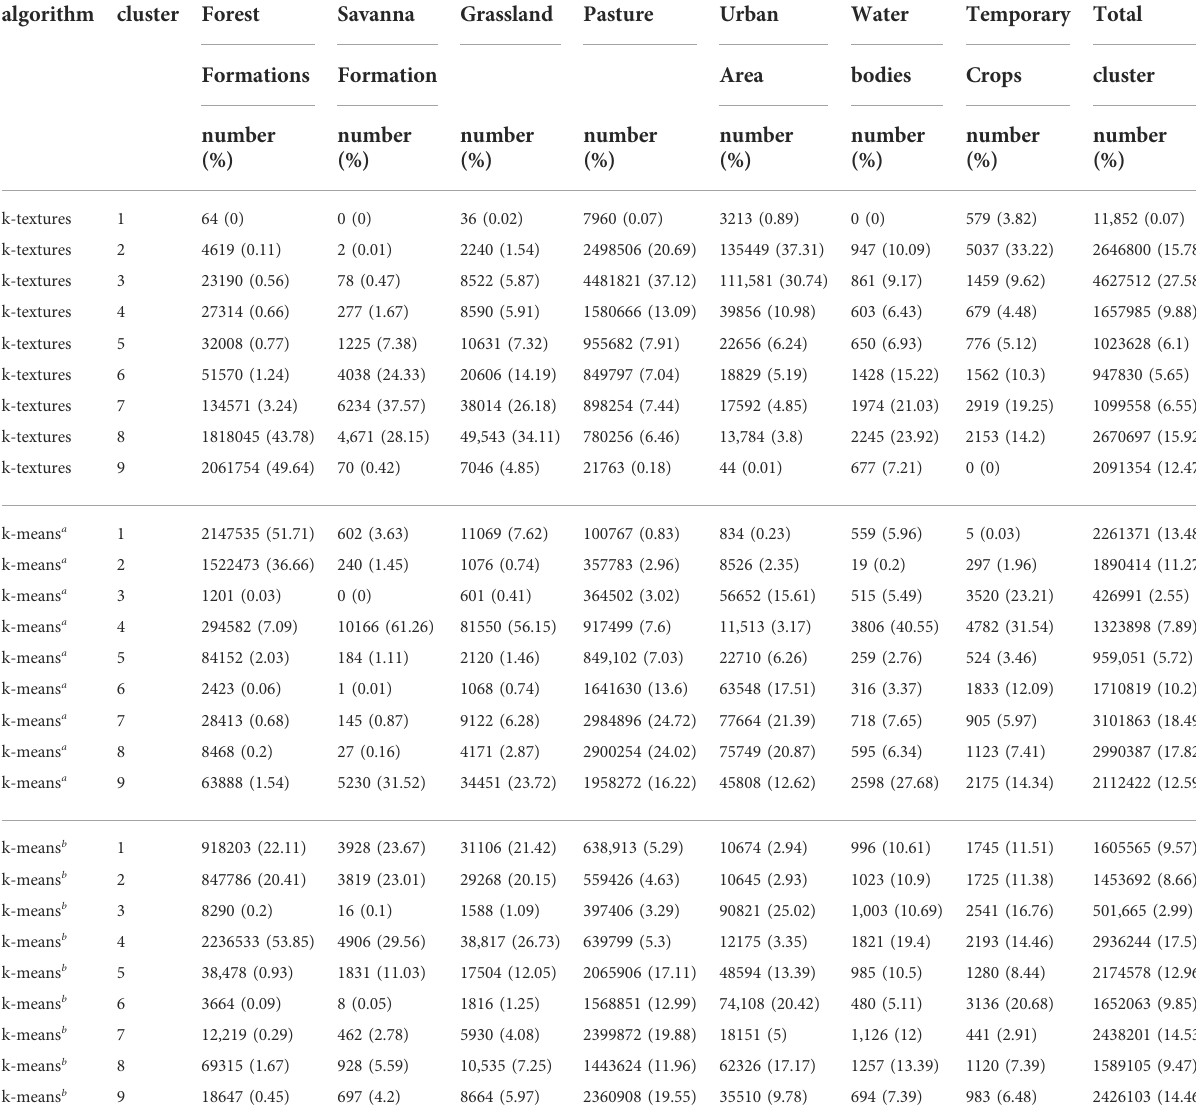
TABLE 3 Distribution of the clusters of k-textures and k-means by Mapbiomas landcover classes. algorithm cluster